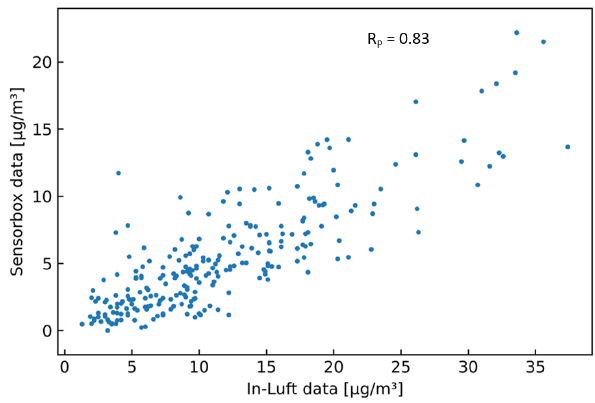
Figure 14. PM 10 hourly mean data recorded with mobile pilot sensor-box 6 located in Luzern in the period from 7 July 2021 to 2 September 2021, compared to hourly mean data recorded at the in-luft station located in Luzern. Number of mean hourly values: 252; Resulting correlations: R P = 0.83, R S = 0.80.